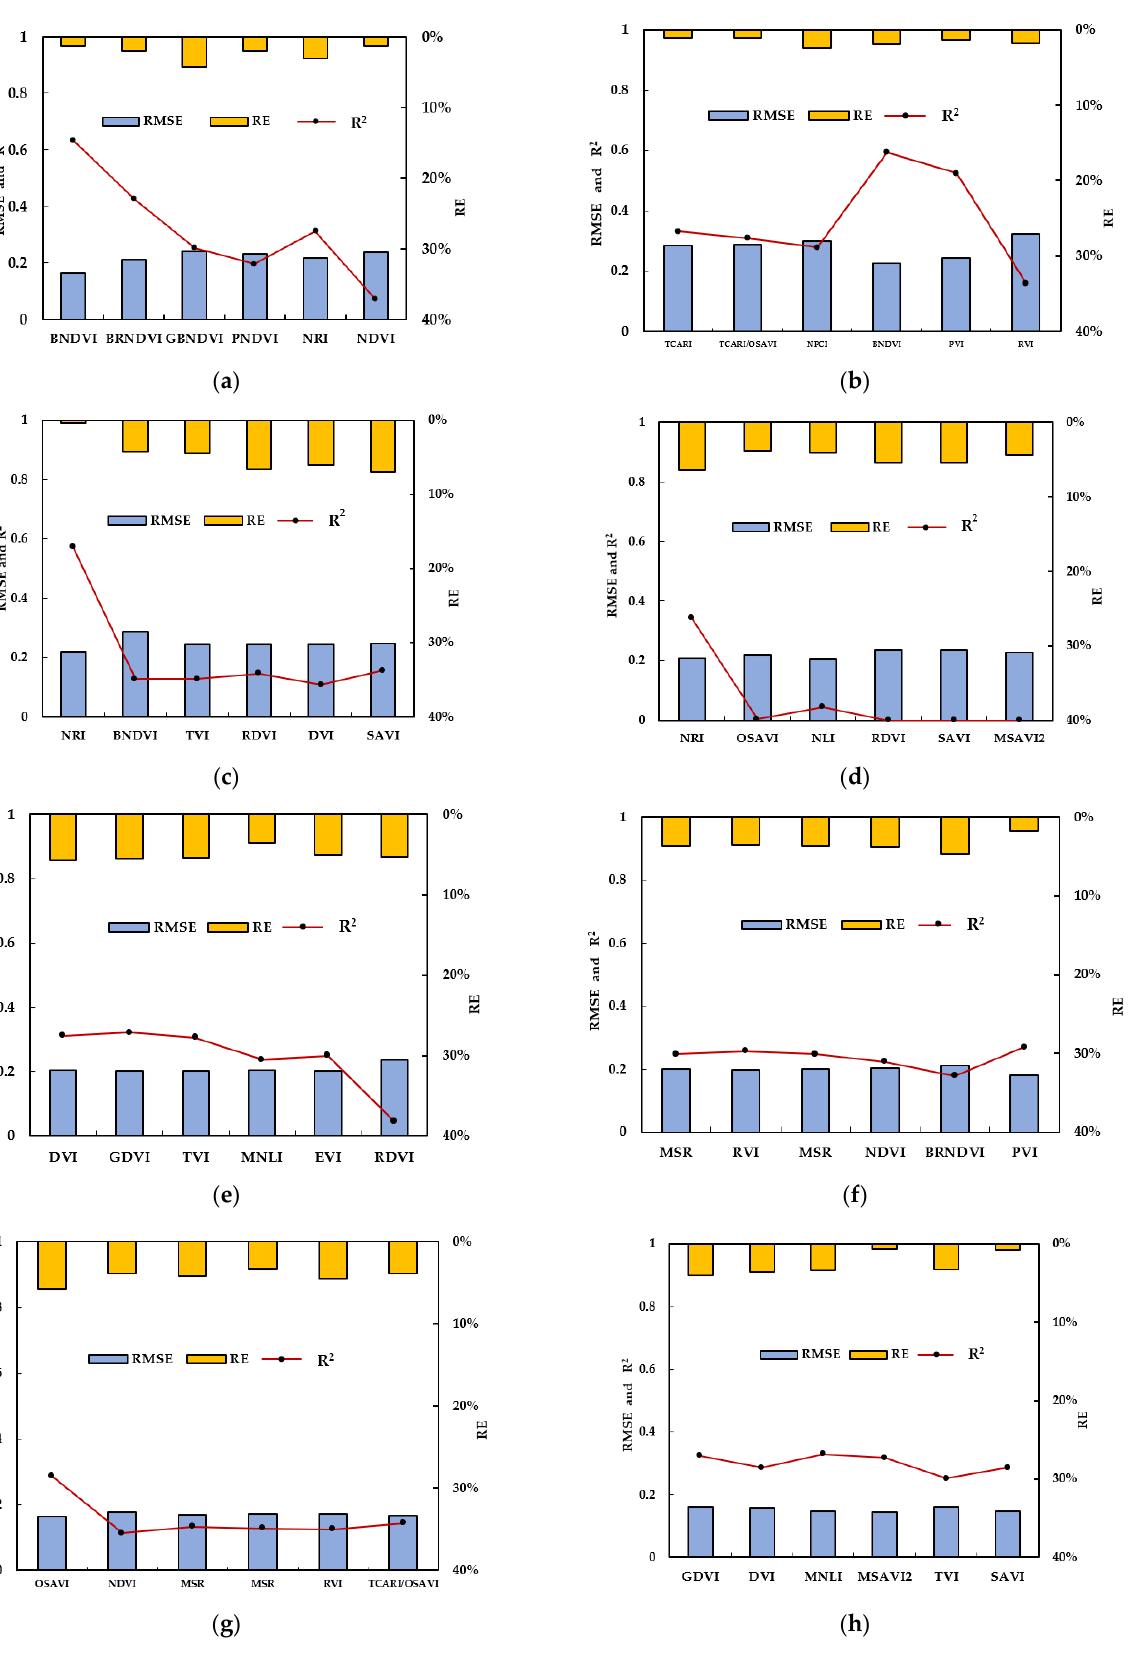
Figure 3. The top six multispectral indices of summer maize at the V6 ( a ), V10 ( b ), V12 ( c ), VT ( d ), R1 ( e ), R2 ( f ), R3 ( g ), and R6 ( h ) growth stages and their life cycle diagnostic